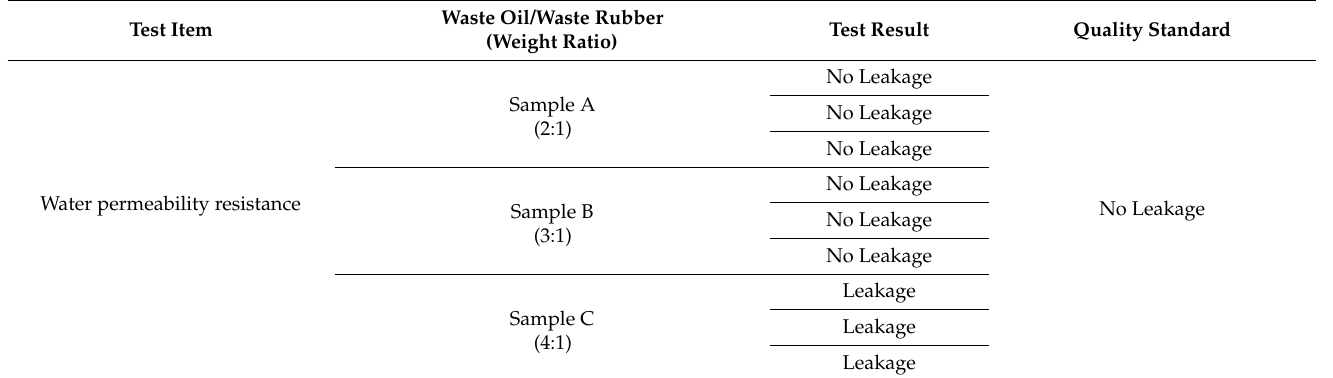
Table 5. Water permeability resistance by sample of W-SPRG.